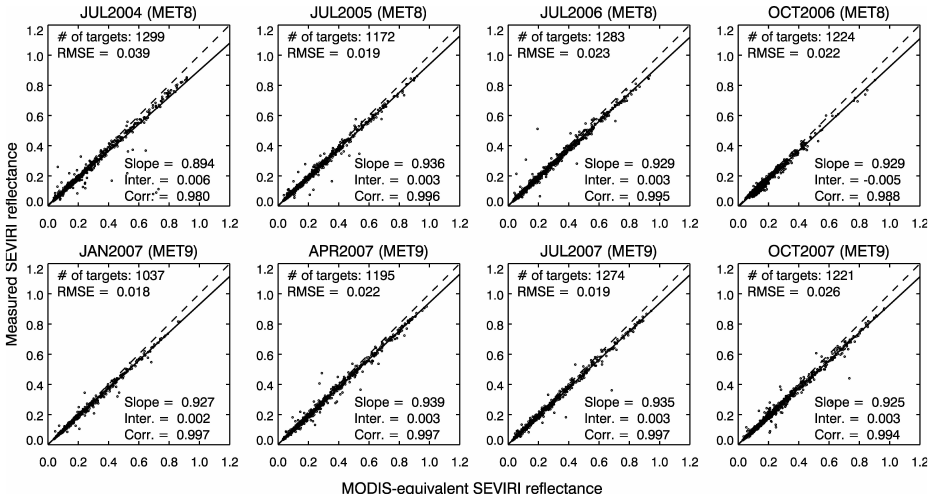
Fig. 7. Scatter plots of MODIS-equivalent SEVIRI vs. measured SEVIRI 0.640-µm channel reflectances of (top) Meteosat-8 and (bottom) Meteosat-9 from Method 1. Regression lines are given as black solid lines along with associated statistics. Dashed lines represent perfect matches.